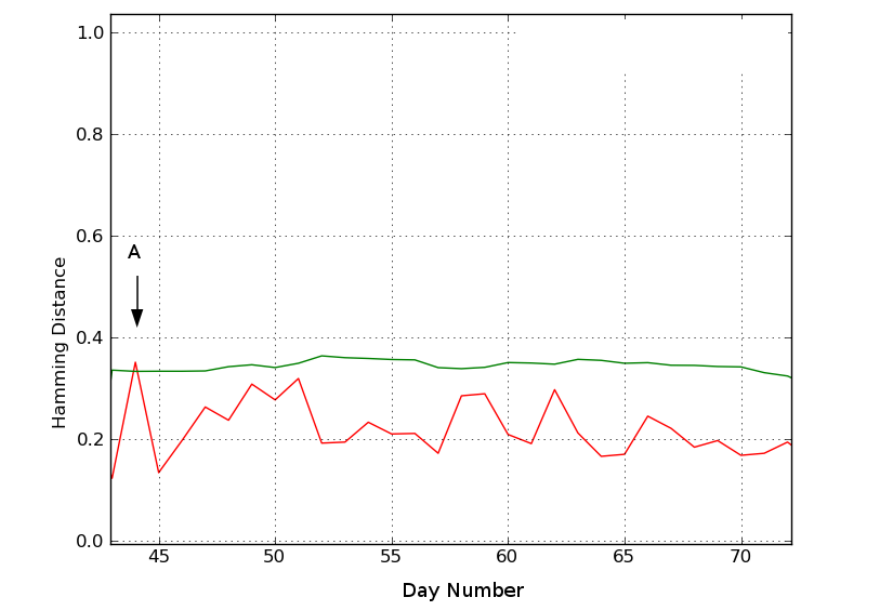
Figure 10. Location 3. Each day’s Hamming distance compared to its reference day using n = 21 days and τ = 60 s. The green line is the threshold calculated by Equation (2). Distances exceeding the threshold are indicated by an arrow and represent a deviation (green line is calculated threshold, red line is hamming distance). ‘A’ indicates the detected deviating